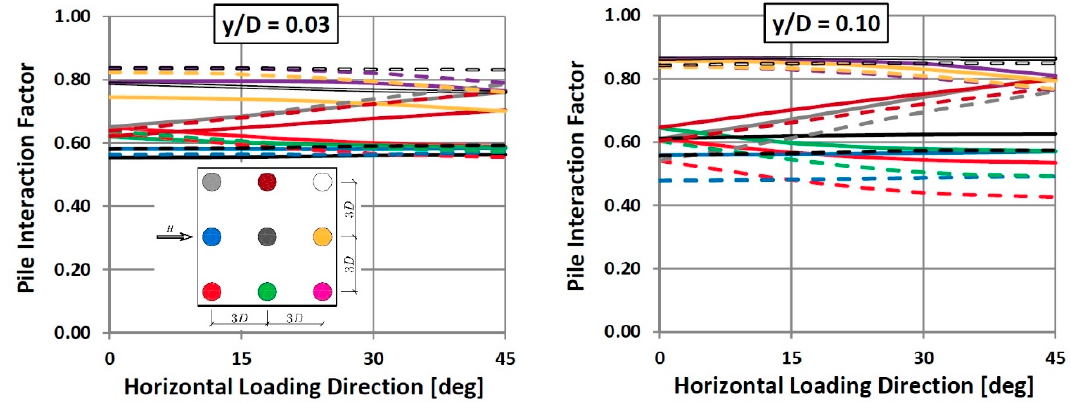
Figure 13. Pile interaction factors for square 3 × 3 pile group ( s x = 3 D , s y = 3 D ). Different colors denote piles inside the pile group. Full lines—loose sand; dashed lines—dense sand.